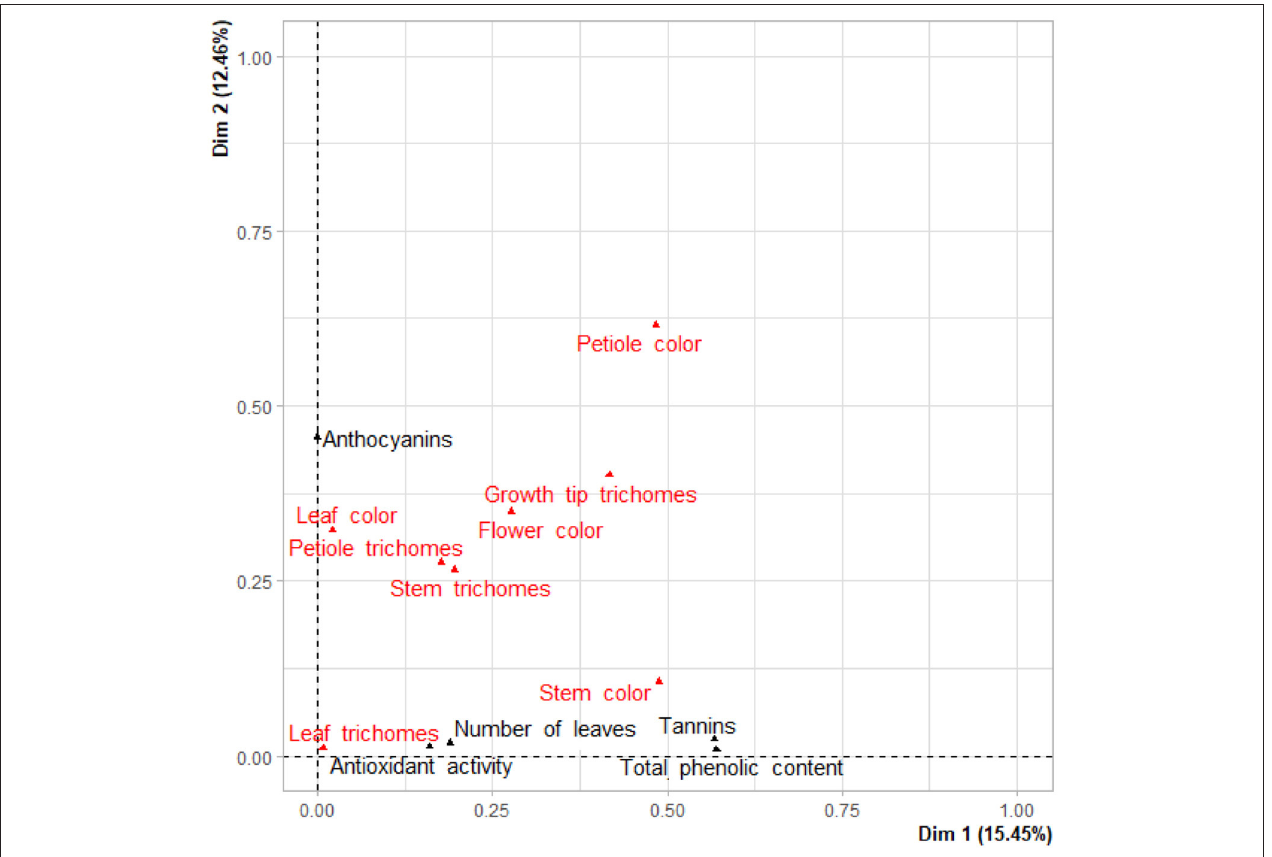
FIGURE 5 | Factor map positioning qualitative (in red) and quantitative (in black) variables on first and second